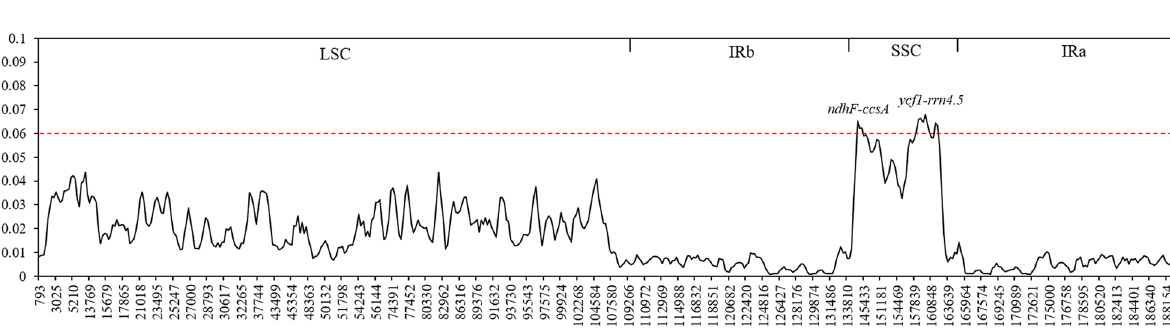
Figure 3. Comparative analysis of the nucleotide variability ( Pi )values of 55 Allium